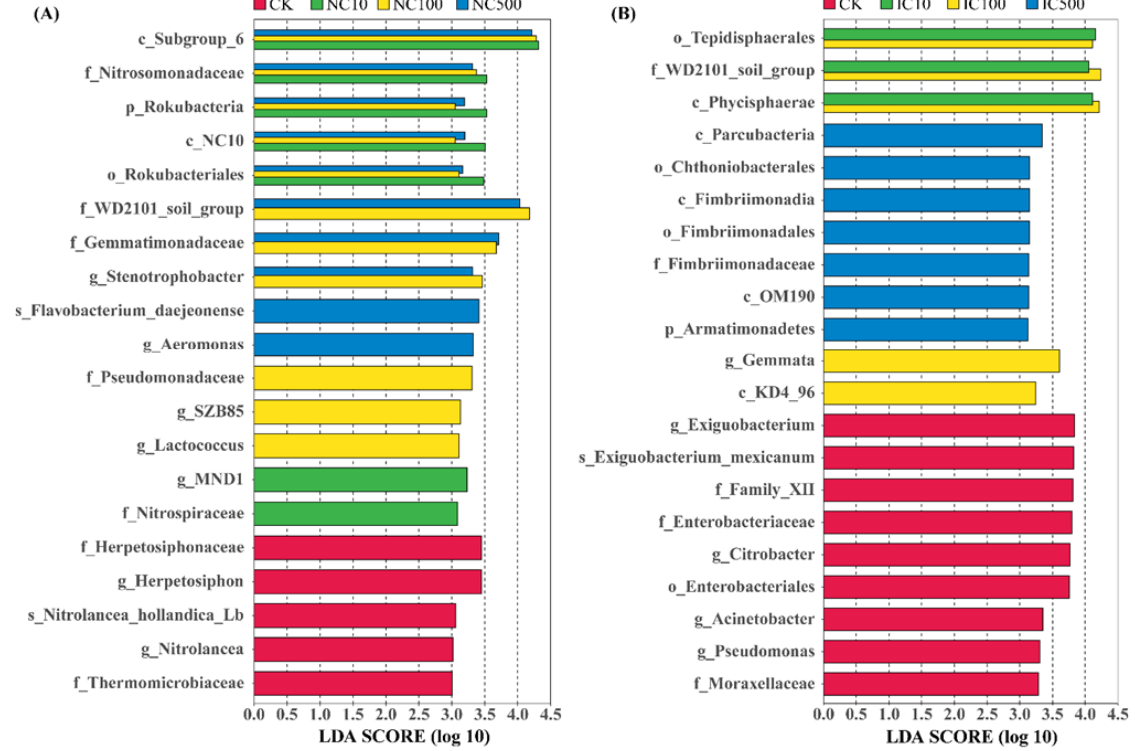
Figure 4. LDA scores of bacterial taxa in NC ( A ) and IC treatments ( B ). The biomarkers in each NC or IC treatment were defined as those significantly enriched only compared to CK, while the biomarkers of CK were those with significantly different abundances compared to all NC or IC treatments. A significance level of p < 0.05 and an effect size threshold of 3 were used for all the biomarkers. The lowercase prefix letters indicate the taxonomic level of the biomarker: p = phylum; c = class; o = order; f = family; g = genus; s = species.